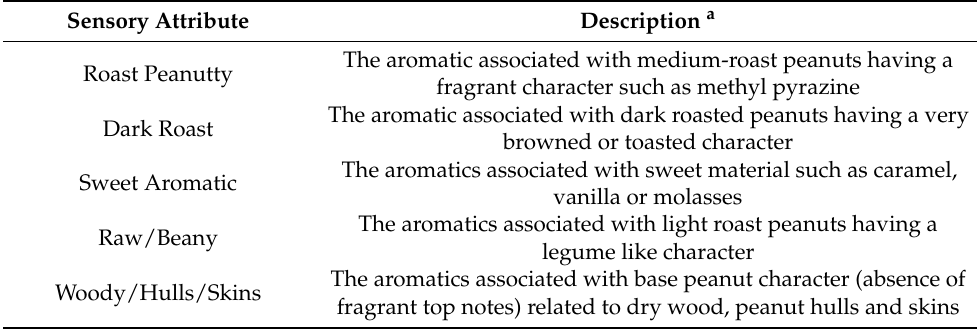
Table 1. Flavor sensory attributes as obtained from the expert panel. Sensory Attribute Description a The aromatic associated with medium-roast peanuts having a Roast Peanutty fragrant character such as methyl pyrazine The aromatic associated with dark roasted peanuts having a very Dark Roast browned or toasted character The aromatics associated with sweet material such as caramel, Sweet Aromatic vanilla or molasses The aromatics associated with light roast peanuts having a Raw/Beany legume like character The aromatics associated with base peanut character (absence of Woody/Hulls/Skins fragrant top notes) related to dry wood, peanut hulls and